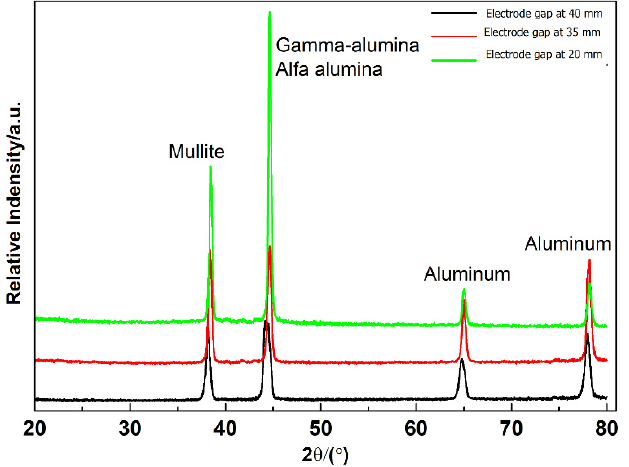
Figure 12. XRD for PEO coatings generated from the experimental configuration of 197 V and 20 mm, 35 mm, 40 mm electrode distances.